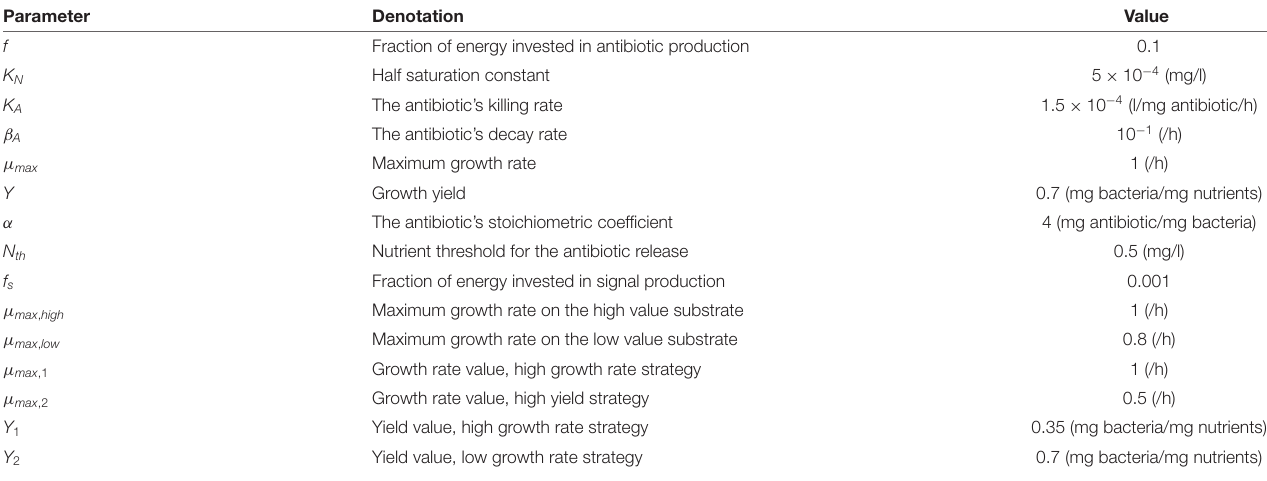
TABLE 1 | Parameter